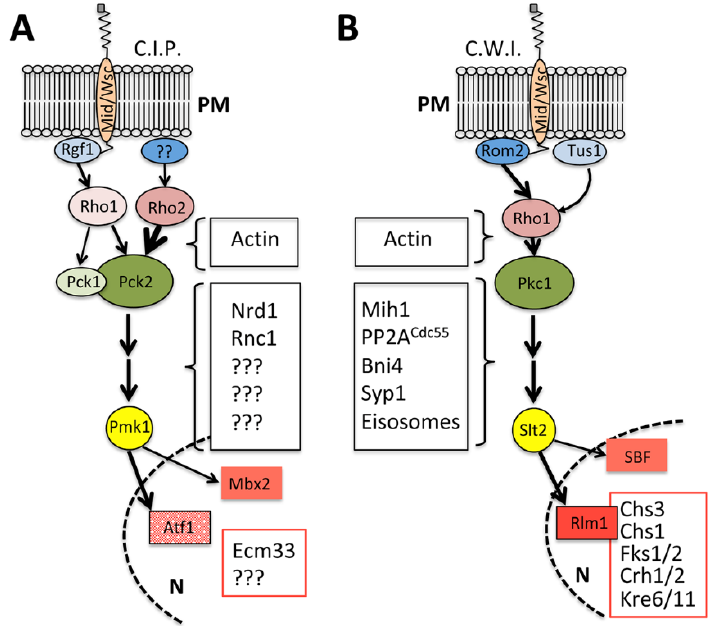
Figure 1. The cell integrity cascade in yeast. ( A ) The cell integrity pathway (CIP) in Schizosaccharomyces pombe . ( B ) The cell wall integrity pathway (CWI) in Saccharomyces cerevisiae . Both cascades signal from the mechanosensors in the PM (Mid/Wsc) to the transcription factor in the nucleus (N). Red boxed proteins are those for which expression is transcriptionally regulated by the cascade and are involved in the cell wall and/or septum assembly. Black boxed proteins represent cytosolic targets of the cascade at different levels that are related to septum assembly. For additional description of the cascade, see text.